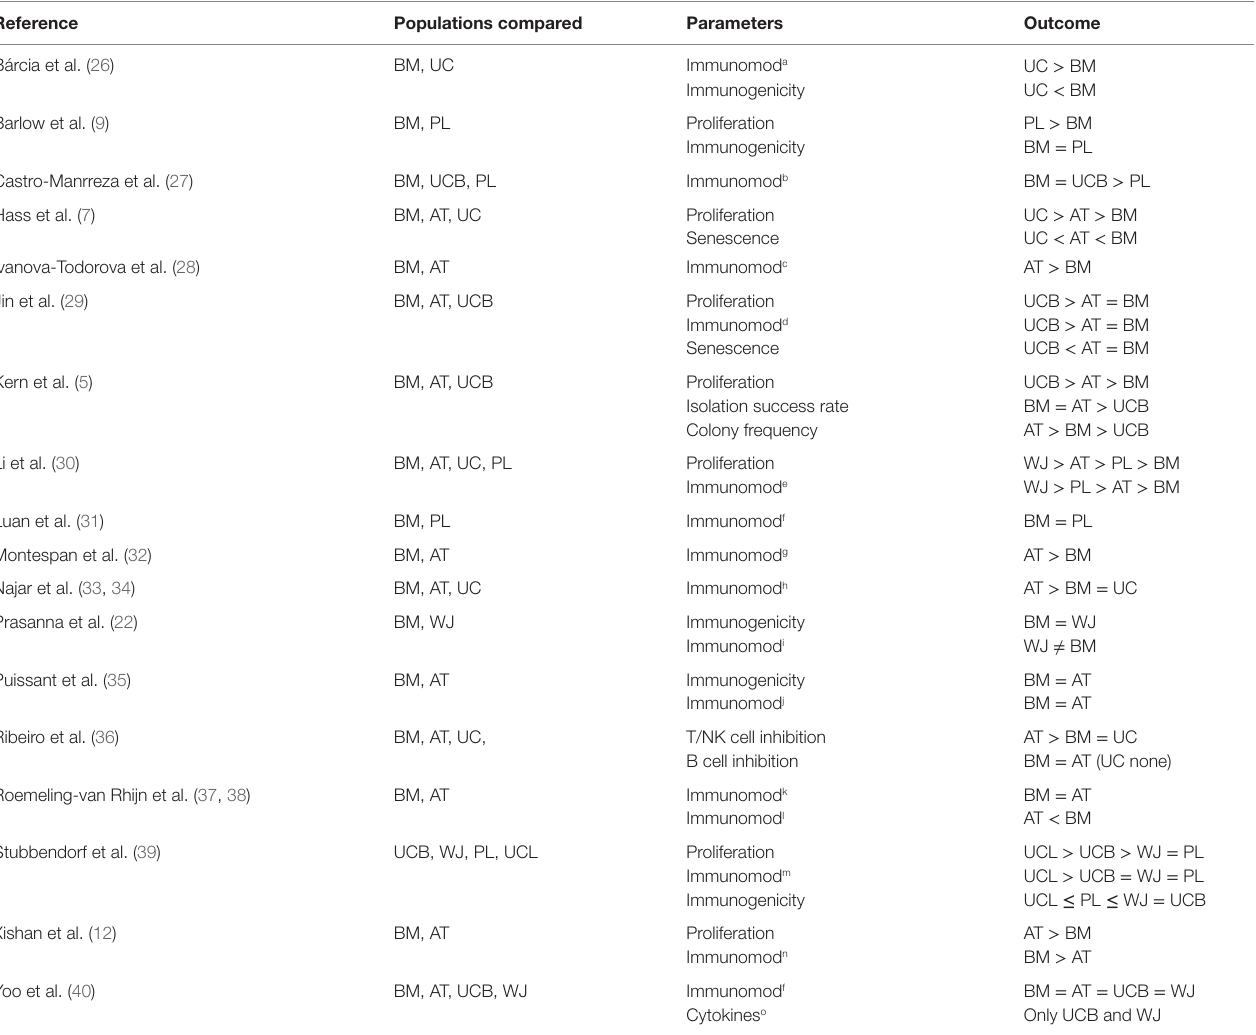
TABLe 1 | Studies directly comparing different sources of MSCs, reporting differences in immunomodulatory